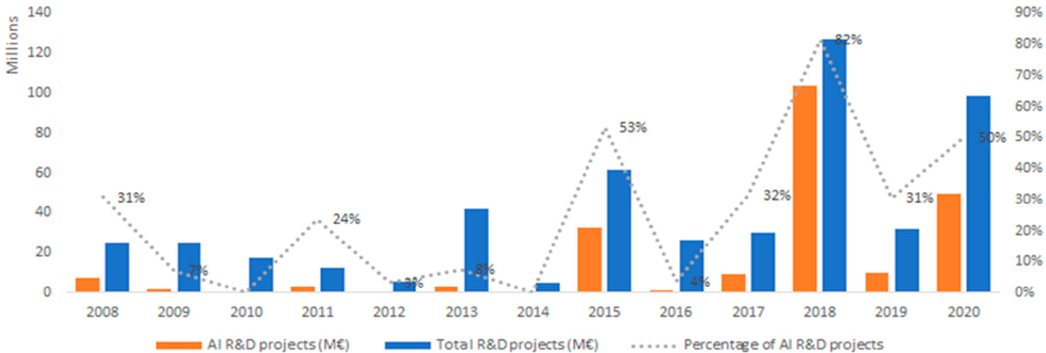
Table 3. Portuguese R&D project data from 2008 to 2020.